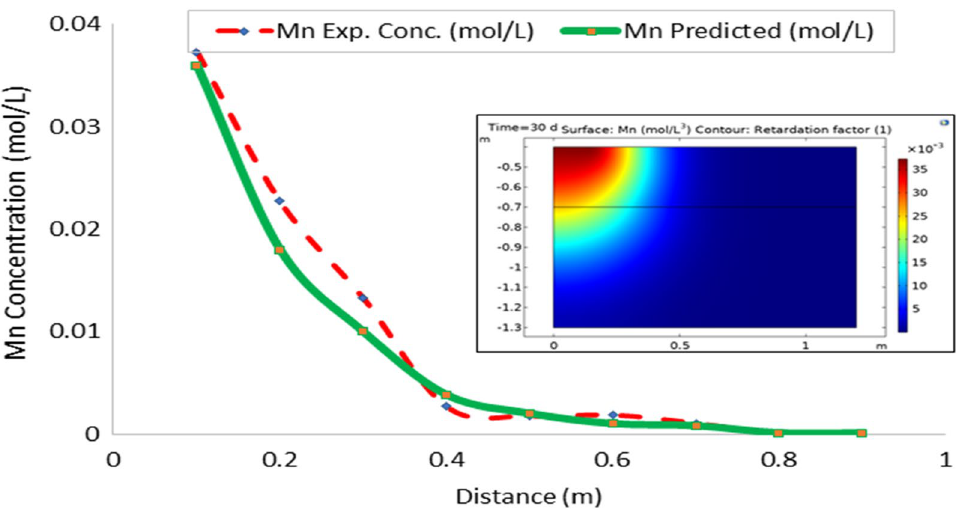
Figure 14. Mn transport in dumpsite soil of the study